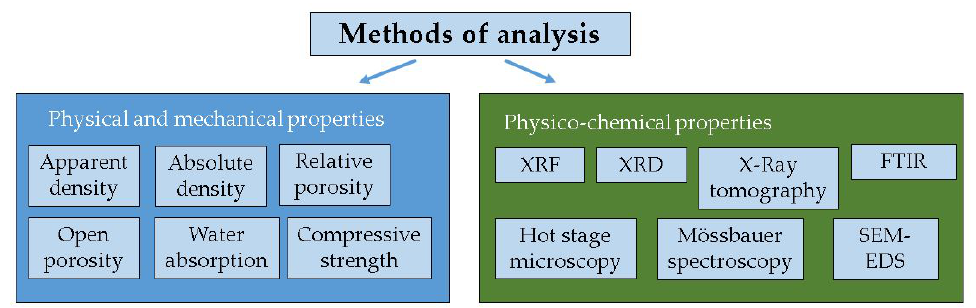
Figure 1. Methods of analysis of precursors and obtained geopolymers.